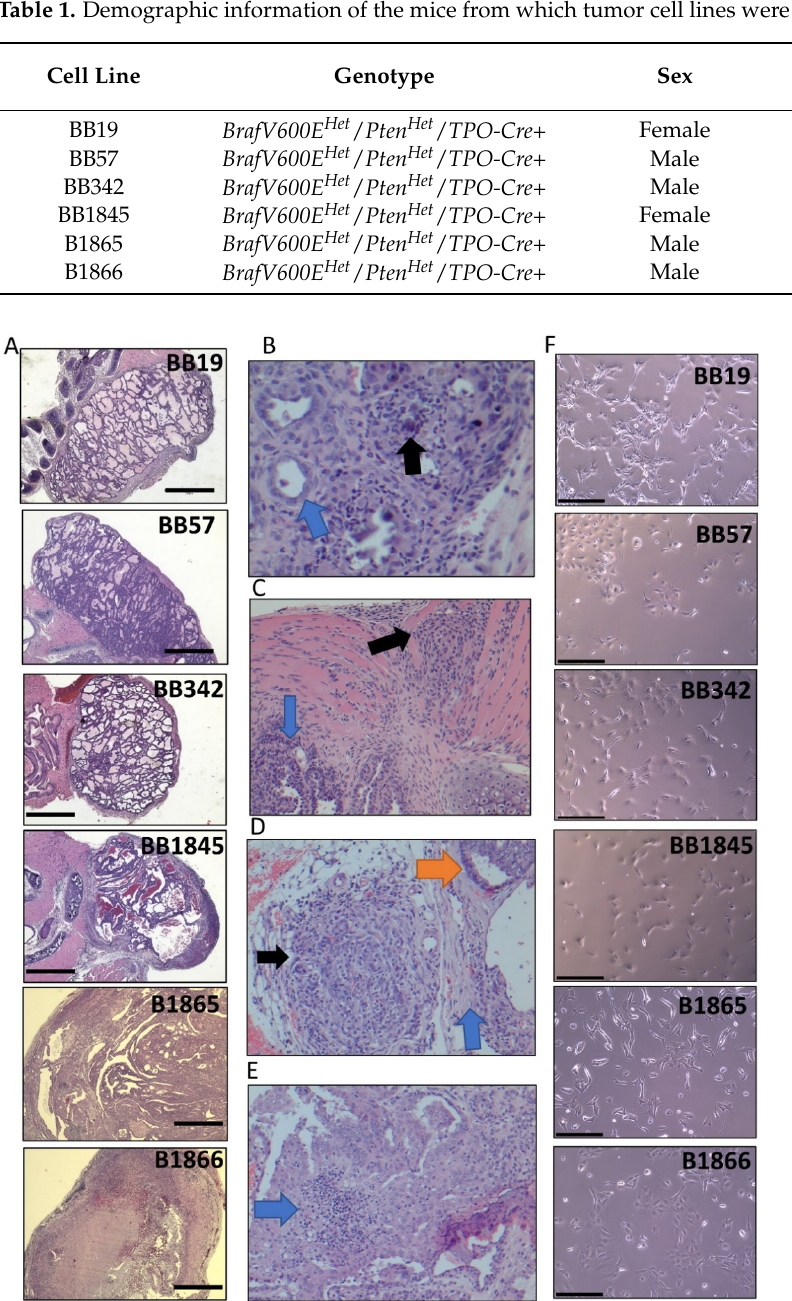
Figure 1. Histology and pathological features of Braf V600E driven murine thyroid tumors and the morphology of stable tumor cell lines derived from them. ( A ) Hematoxylin and eosin (H&E) stain- ing of de novo tumors for cell lines BB19, BB57, BB342, BB1845, B1865, and B1866. Scale bar in black is 750 µM. ( B ) High magnification of BB57 H&E showing papillary thyroid carcinoma with fine chromatin, nuclear grooves (blue arrow) and psammoma bodies (black arrow). ( C ) High magnifi- cation of BB57 H&E showing papillary thyroid carcinoma (blue arrow) with invasion into the mus- cle (black arrow). ( D ) High magnification of an extra-thyroidal nodule outside of the thyroid capsule (blue arrow), adjacent to intra-thyroidal tumor (orange arrow) in B1866. ( E ) High magnification of B1866 H&E showing moderately differentiated papillary thyroid carcinoma, which maintains pa- pillae and grooves but has associated necrosis (blue arrow). ( F ) Representative phase contrast im- ages of the individual cell lines in culture derived from the indicated tumors. Scale bar in black is 300 µM.